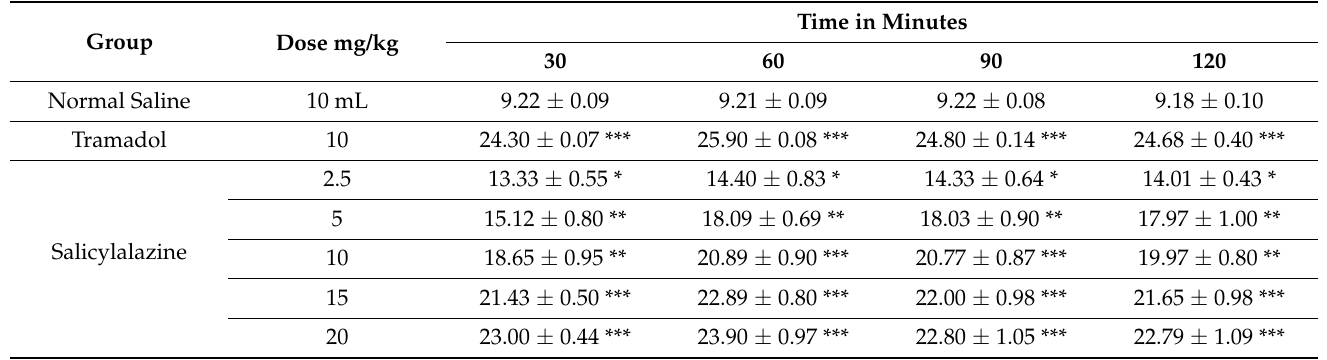
Table 1. Analgesic effect of salicylalazine isolated from M. biflora .